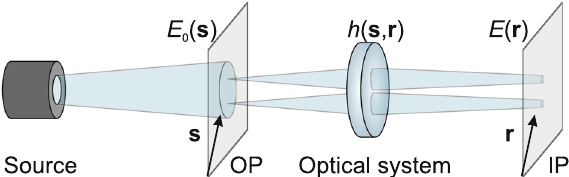
Fig. 1 General scheme of an imaging setup. See the text for details. A magni fi ed or demagni fi ed image of an object placed at the object plane OP is formed by the optical system at the image plane